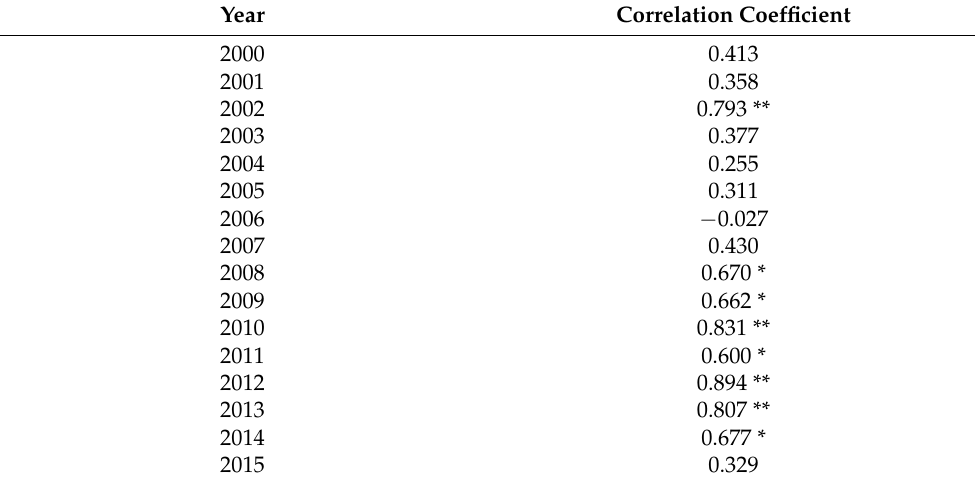
Table 3. Correlation analysis between SM and air temperature.